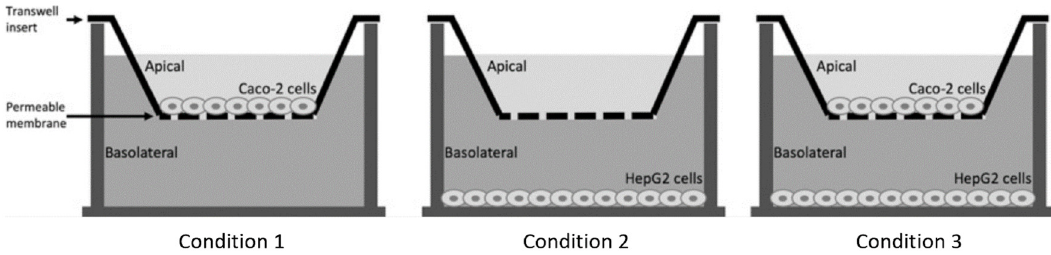
Figure 2. Schematic overview of different experimental conditions were performed in the transwell system.